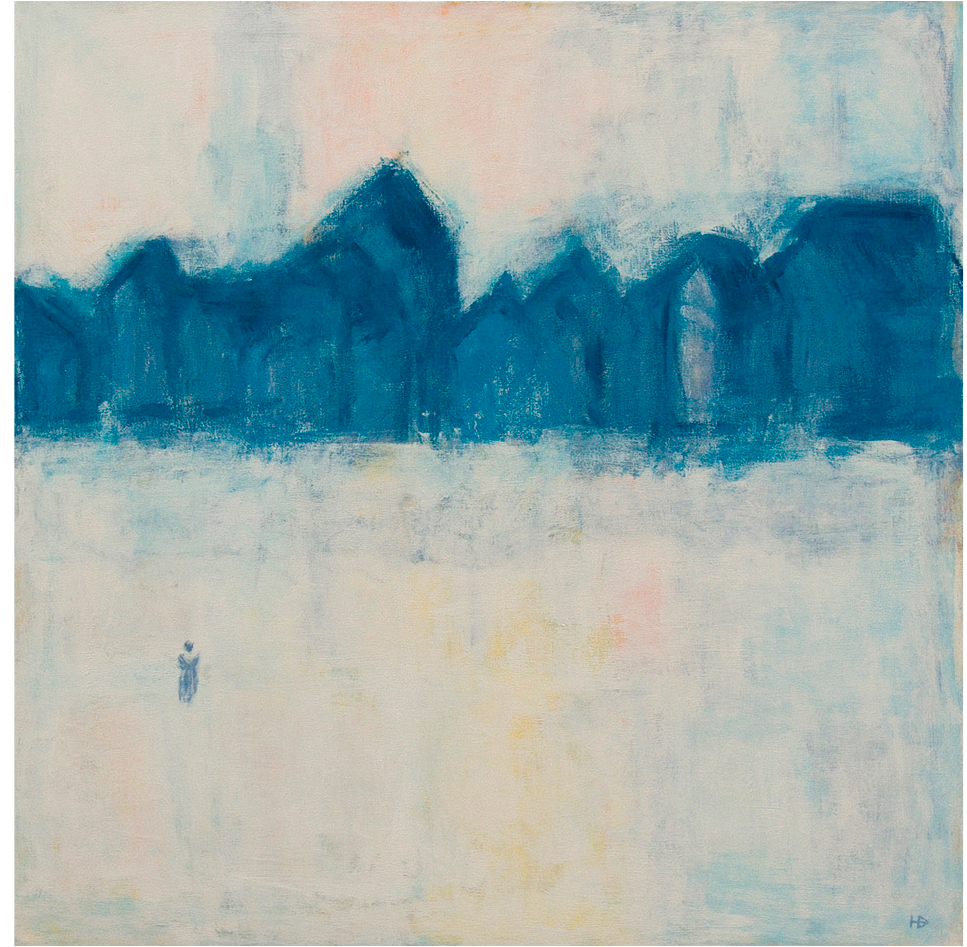
Figure 3. Hannah Bischof, “ Papenburg 1923–1927 ”, acrylic on canvas, Berlin 2015, © Ben Bischof. Acting as a “memory object”, the Zyklus allows us to learn about and follow Maria’s story, but at the same time to perceive how her granddaughter internalized it: through Hannah’s artistic elaboration, something of Maria reaches us. It is exactly as a “memory object” that the canvases become the place where the past connects with the present and allows us, for an instant, to meet the victim. allows us, for an instant, to meet the